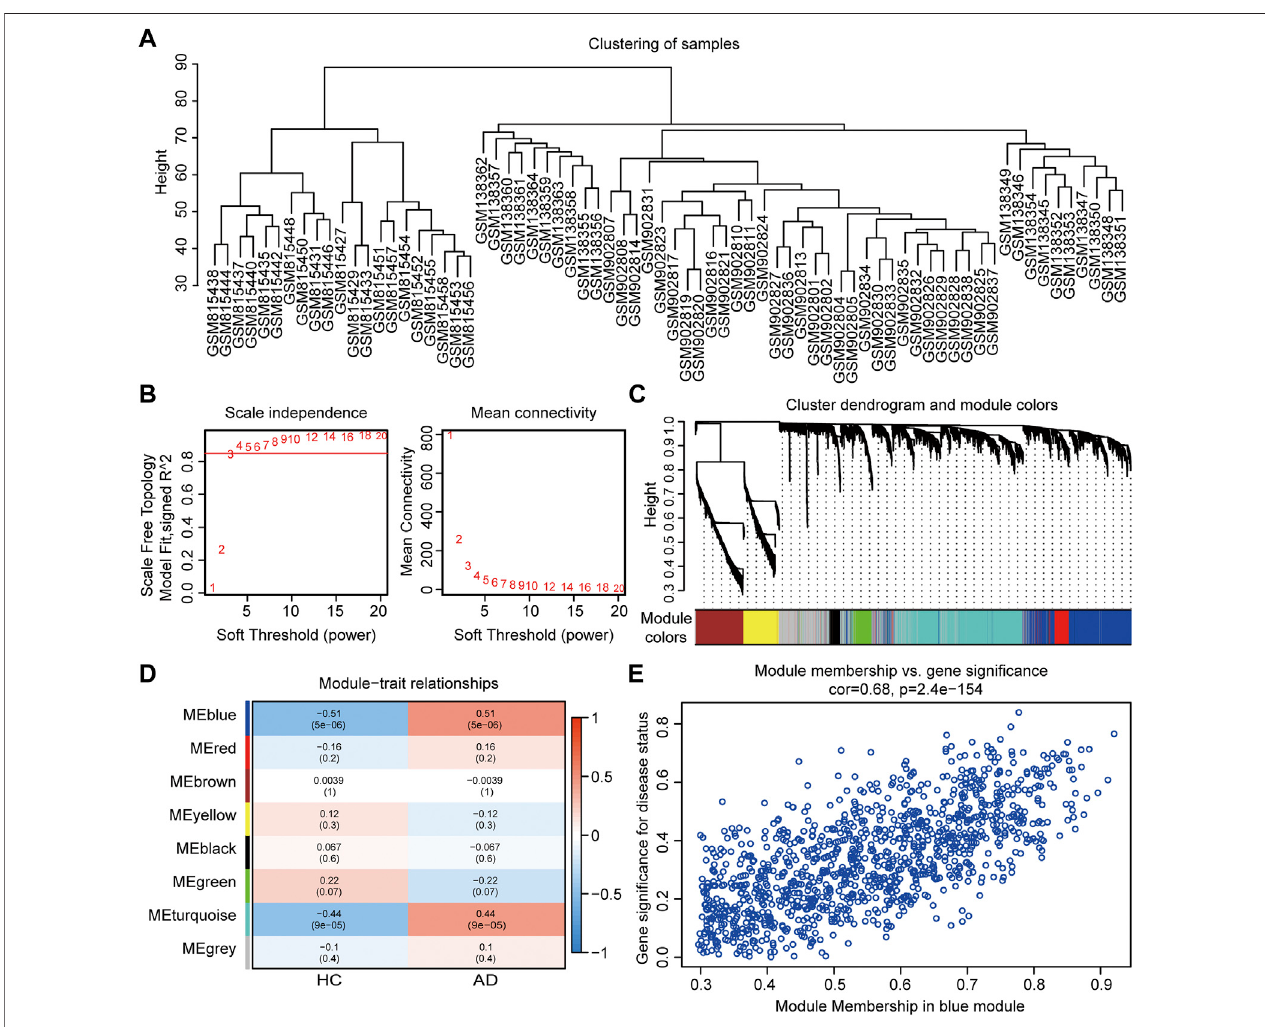
FIGURE 3 | Co-expression network assessment using WGCNA. (A) Clustering dendrograms of DEGs from “ Batch correction. ” (B) Assessment of the scale-free fi tnessindex and mean connectivityfor various soft-thresholding powers. (C) Dendrogram ofall thegenesclusteredbasedon dissimilarityin thetopologicaloverlap. (D) Heatmapexhibitingtherelationshipbetweenmoduleeigengenesandclinicaltraits.Eachrowrepresentsacolormodule,andeverycolumnrepresentsaclinicaltrait.The correlation coef fi cient and corresponding p value are shown in each cell. (E) Scatter plot exhibiting genes in the blue module. WGCNA, weighted gene co- expression network analysis; DEGs, differentially expressed genes.